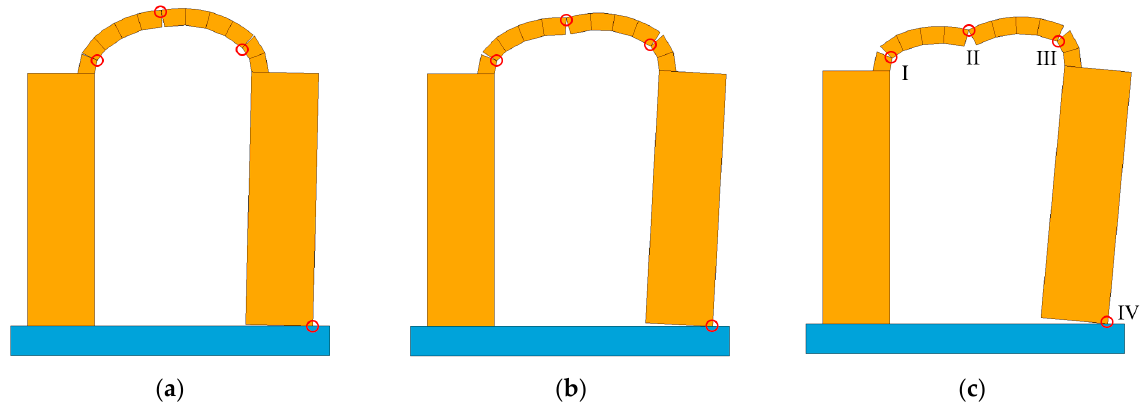
Figure 10. Failure process of the buttressed basket-handle arch with β = 180 ◦ : ( a ) t = 1.0 s; ( b ) t = 1.3 s; ( c ) t = 1.5 s.